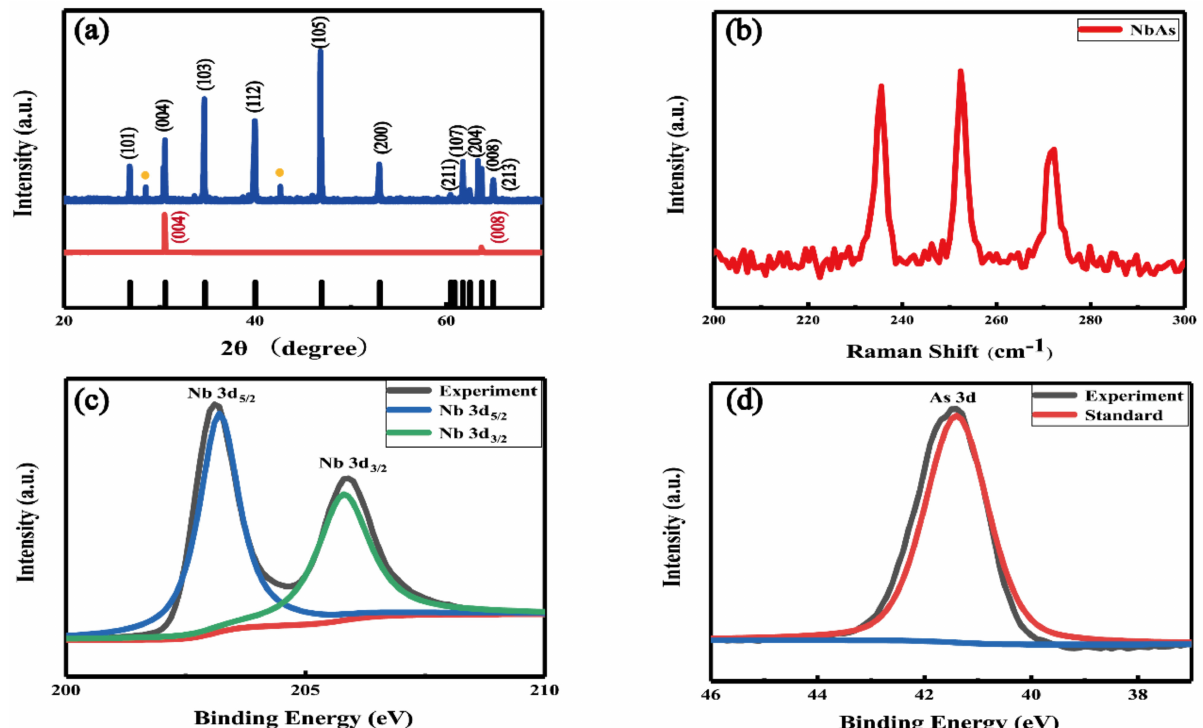
Figure 3. ( a ) XRD pattern of NbAs crystal powder. The {001} facets of NbAs single crystal (black line in the figure is PDF card of the NbAs and diffraction peaks of the polyarsenides marked by yellow dots). ( b ) Raman spectra of NbAs single crystal. ( c , d ) Typical XPS spectrum of Nb 3d and As 3d core level of NbAs single